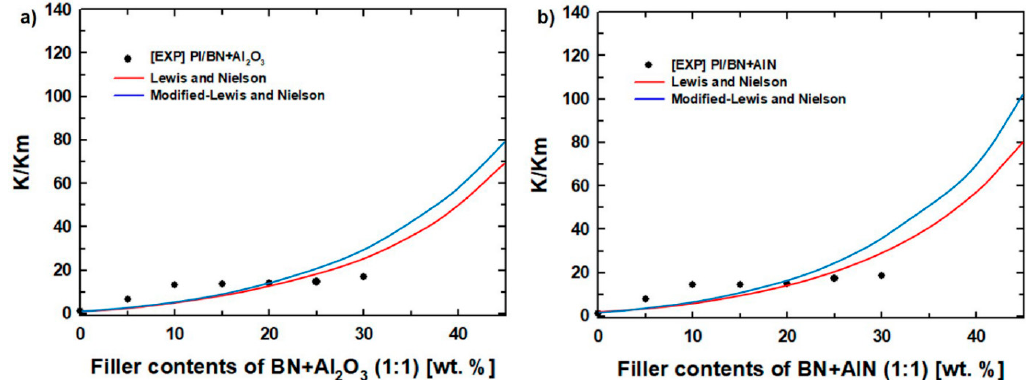
Figure 6. Experimental and theoretical thermal conductivity obtained for the ( a ) PI/BN+Al 2 O 3 and ( b ) PI/BN+AlN composites by using the multiplicative approach model.